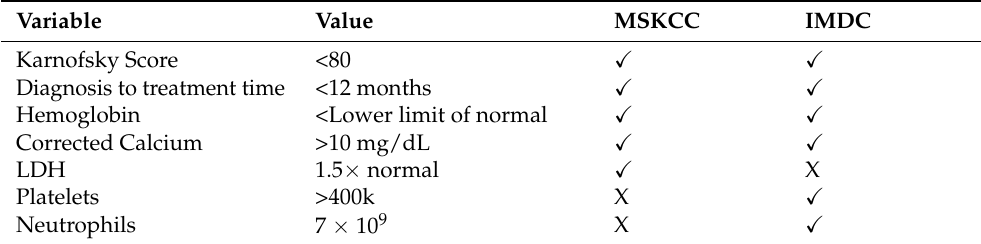
Table 1. Risk factors included in the MSKCC and IMDC prognostic models. Patients with 0 risk factors are designated as favorable risk, one to two risk factors—intermediate risk, and those with ≥ 3 risk factors—high risk. (cid:88) included in model. X not included in model.